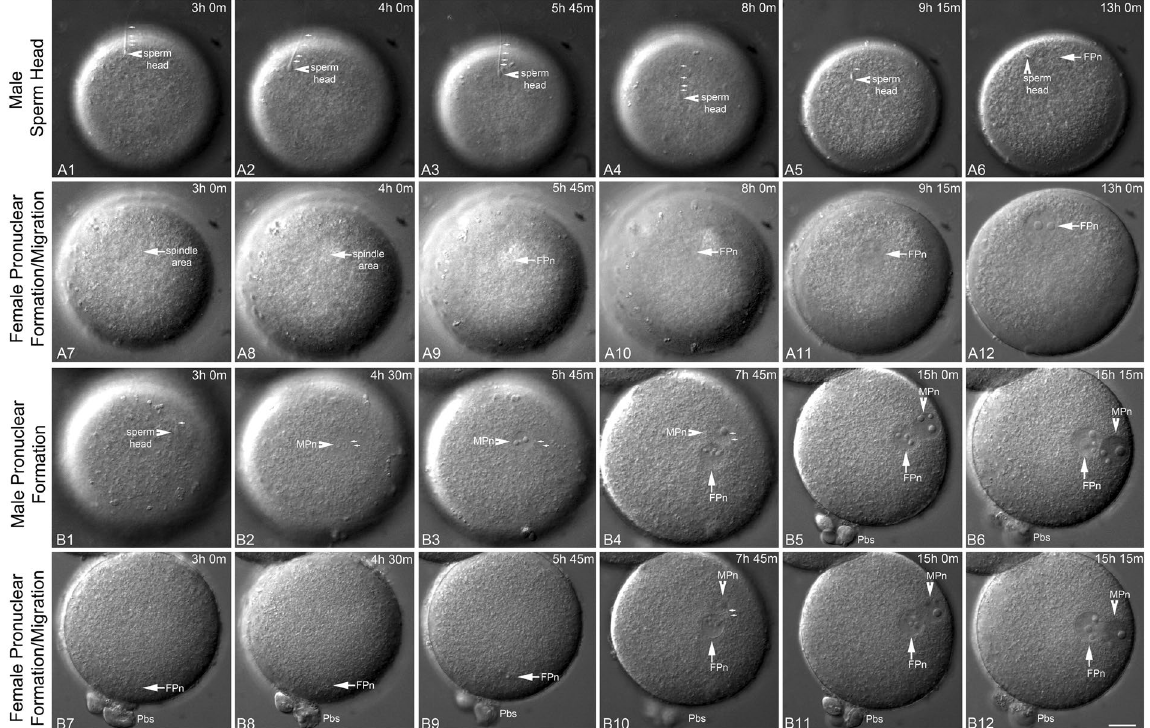
Figure 1. Selected TLVM panels of Rhesus sperm incorporation and pronuclear apposition during IVF. ( A1 – A6 ): male sperm head events during IVF (arrowheads) showing incorporation ( A1 , A2 ) followed by cortical rotation, first toward the site of the oocyte’s spindle region ( A3 – A4 ) and subsequently to a distal cortical site ( A5 – A6 ). The sperm head shows firm attachment to the oocyte’s cortex during penetration, even as cortical rotation powers sperm translocation. The sperm head is delayed in conversion to a fully decondensed MPn. ( A7 – A12 ): corresponding image panels from the TLVM video showing the position of the second meiotic spindle ( A7 – A8 , arrows), FPn formation ( A9 – A11 , arrows) and migration to the cortically residing sperm head (A12, arrow), mediated by the assembled sperm aster. Extrusion of the 2 nd PB is not visible in these panels. ( B1 – B12 ). Classical rhesus IVF and pronuclear apposition beginning 3 hrs post-insemination show sperm head plasma membrane penetration ( B1 , arrowhead), MPn formation ( B2 – B3 , arrowheads), male and female pronuclear apposition ( B4 : MPn, arrowhead; FPn, arrow), and typical radial cortical parental genome orientation by the middle of interphase, with the MPn closest to the oocyte’s cortex ( B5 – B6 , arrowheads) and the female distal within the cytoplasm (B5-B6, arrows). Note the orientation of the apposed pronuclei is oblique to the A → V axis. ( B7 – B12 ): corresponding images of FPn events. After 2 nd PB extrusion by 3 hrs post-insemination, the FPn forms near the cortex ( B7 – B9 , arrows), swiftly migrates to the MPn utilizing microtubules of the assembled sperm aster ( B10 – B11 , arrows), and ultimately positions distal to the cortically residing MPn ( B12 ; FPn: arrow; MPn: arrowhead). The small arrows trace the sperm axoneme in ( A1 – A5 , B1 – B4) . Time is given in hours:minutes (h:m) post-IVF. All panels represent selected HMC images from a TLVM recording. Bar = 20 µ m.